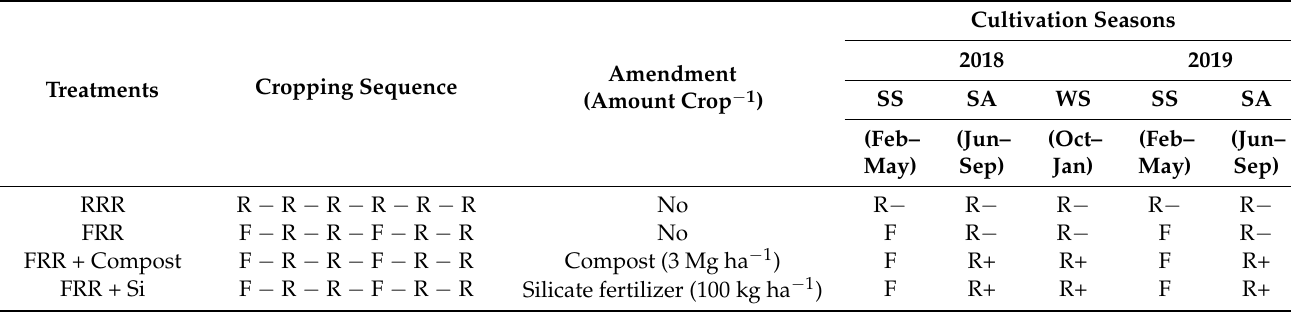
Table 2. The schema of cropping system and soil amendment in field experiment.